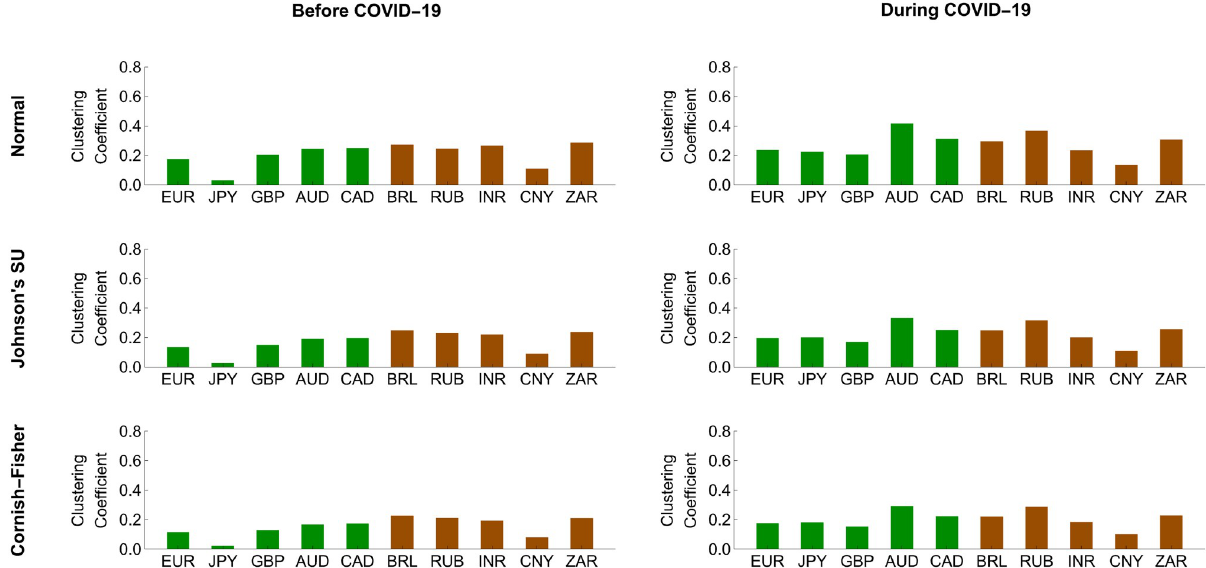
Fig 11. Node clustering coefficients of conditional tail risk networks based on Δ MCoVaR forecasts. Green and brown represent the advanced and emerging forex markets, respectively.